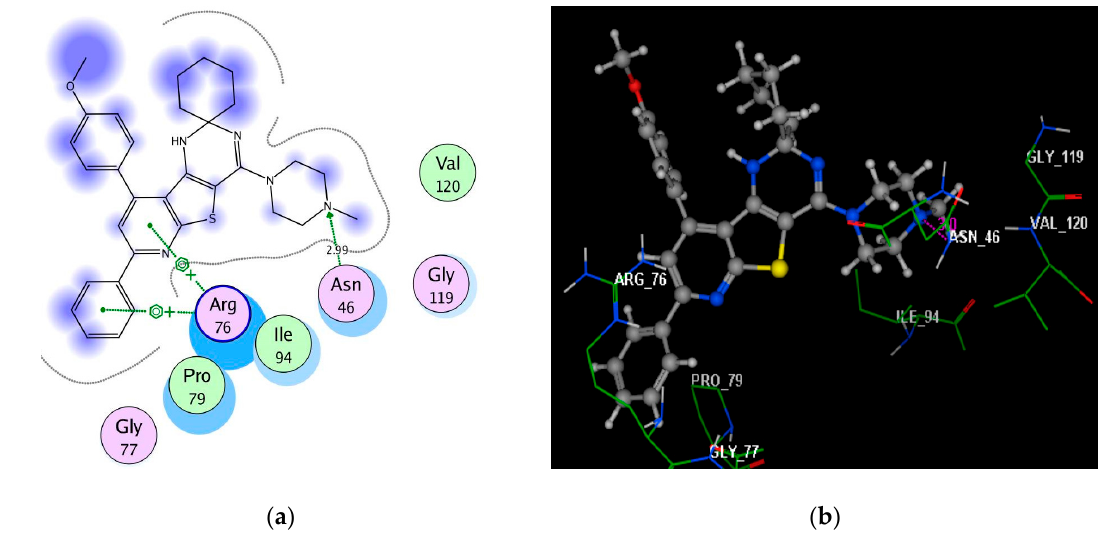
Figure 5. ( a , b ) Diagrams illustrating the 2D and 3D binding patterns of compound 4b onto the ATP-active pocket of E. coli DNA gyrase B kinase (PDB code: 1AJ6),